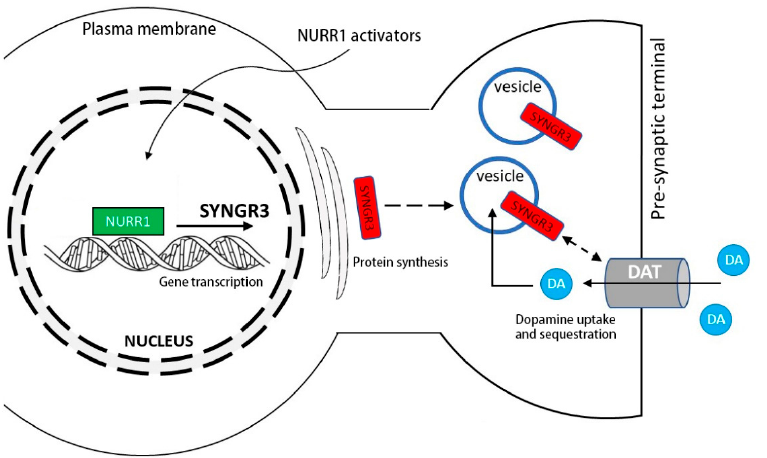
Figure 8. Hypothetic schematic diagram showing a potential role of NURR1 on SYNGR3 expression and dopamine (DA) homeostasis via its interaction with the dopamine transporter (DAT). NURR1 activators may be helpful to maintain dopaminergic synaptic function via SYNGR3, thus presenting a potential therapeutic target to preserve neuronal function in PD. DA: